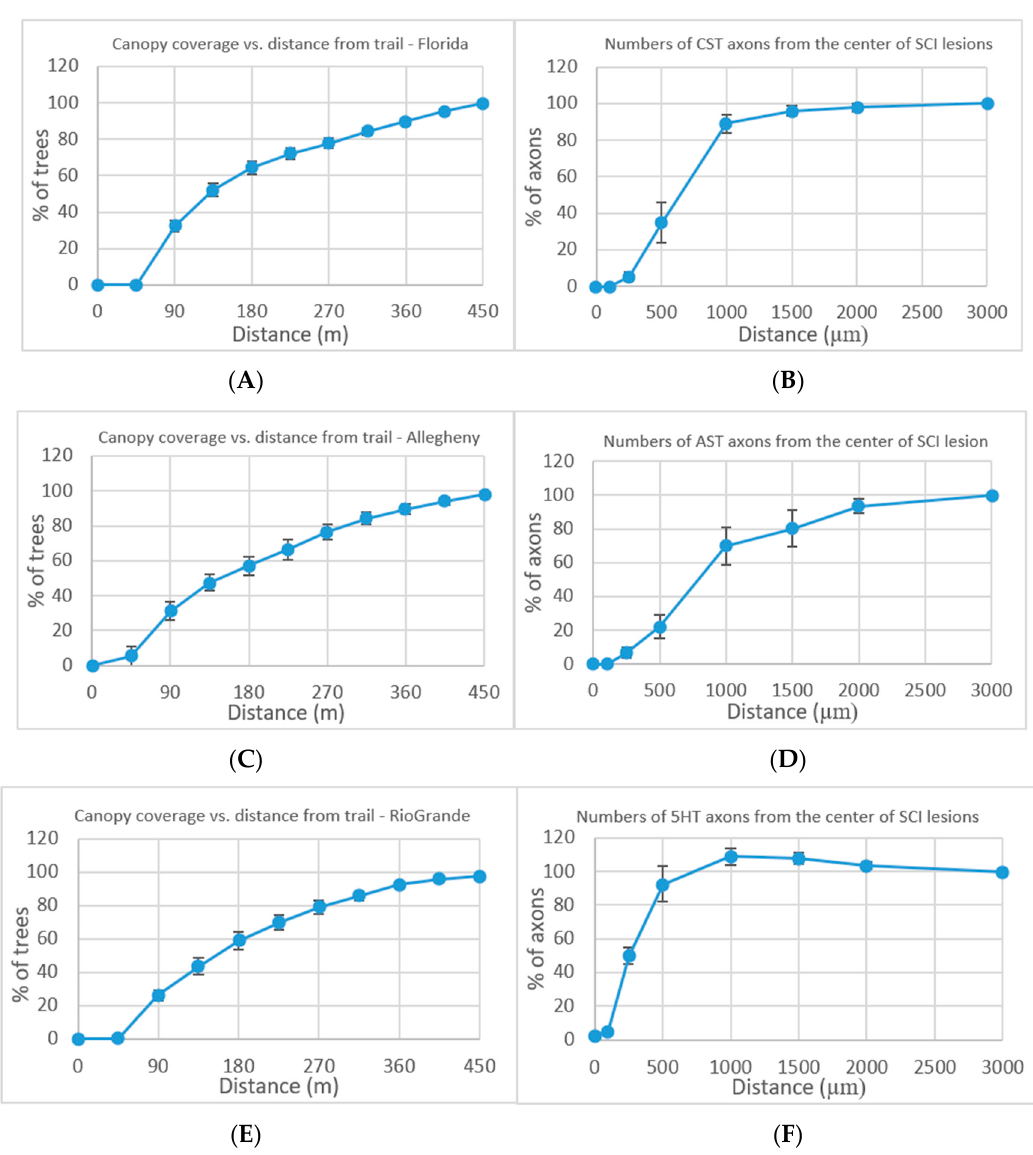
Figure 2. ( A , C , E ), Forest resection performed by trails. Numbers (means ± s.e.m.) of trees at Florida National Forest ( A ), Allegheny National Forest ( C ) , and Rio Grande National Forest ( E ) canopy coverage at various distance from trail lesion center as percentage of total canopy coverage at 450 m proximal. ( B , D , F ), Severe crush spinal cord injuries (SCI) performed on mice [19]. Numbers (means ± s.e.m.) of descending corticospinal tract (CST) ( B ), ascending sensory tract (AST) ( D ), and descending serotonergic (5HT) tract ( F ) axons at various distances from the SCI lesion center as a percentage of the total number of axons present 3 mm proximal (Figure S3).